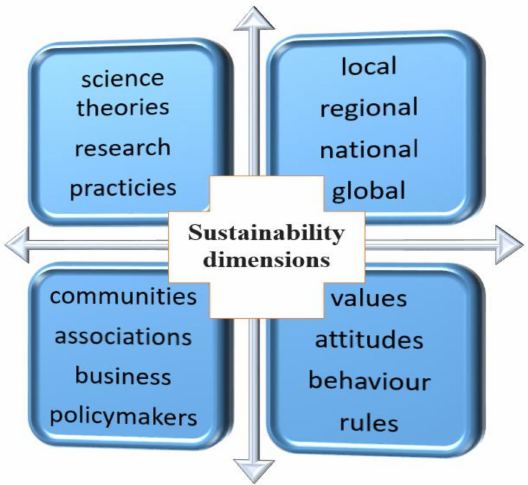
Figure 1. Sustainability